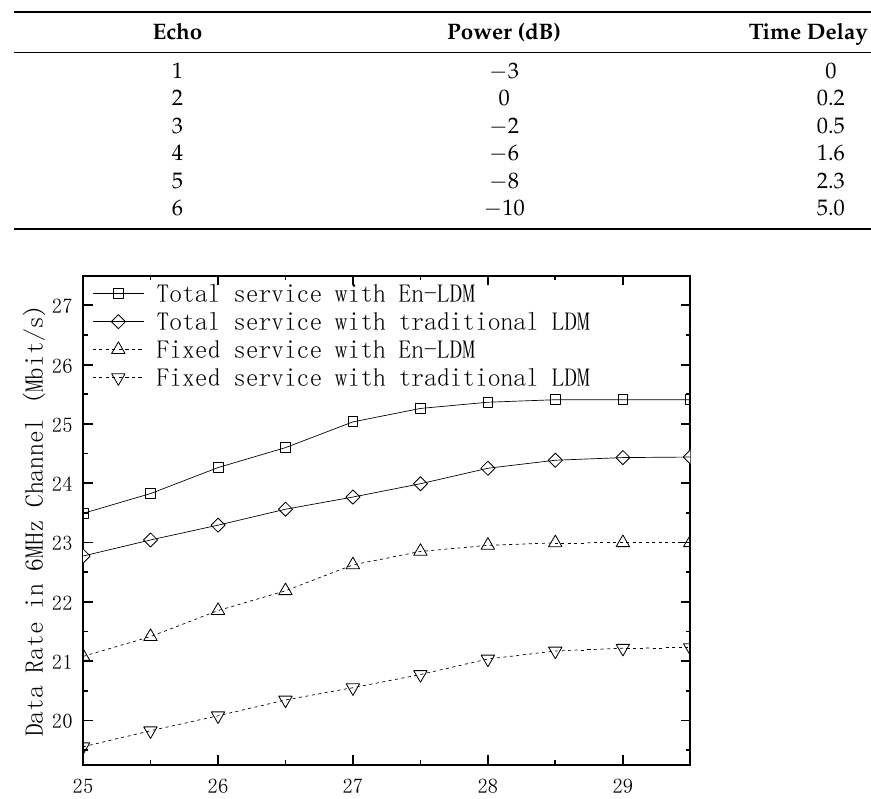
Table 3. Profile of multipath channel model.